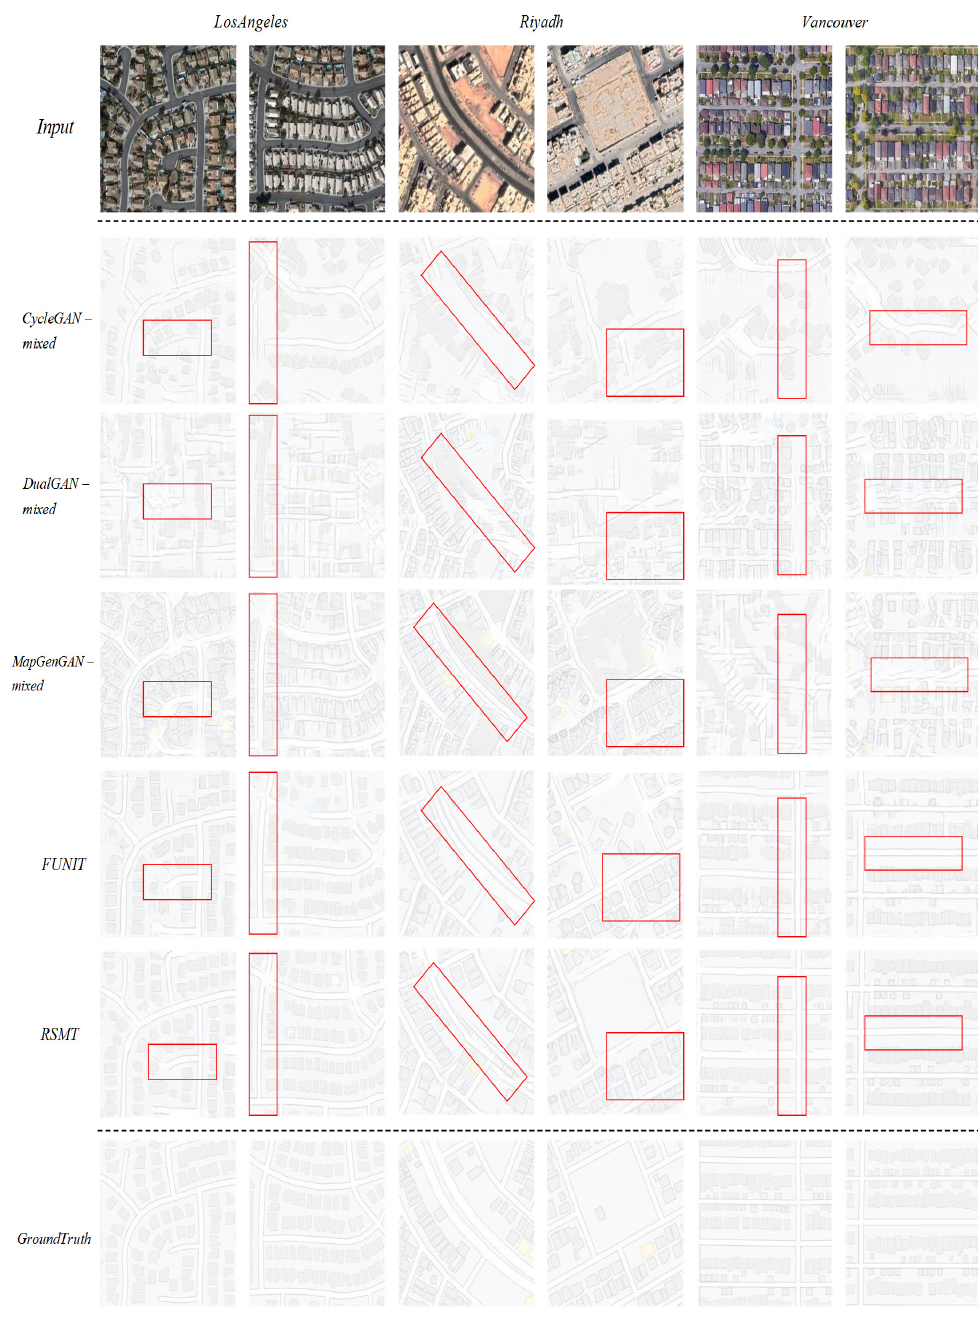
Figure 5. Selected results of remote sensing image-to-map translation performance for three testing datasets. Images from top to bottom: input remote sensing images; translation results of baselines; translation results of our model RSMT; the ground